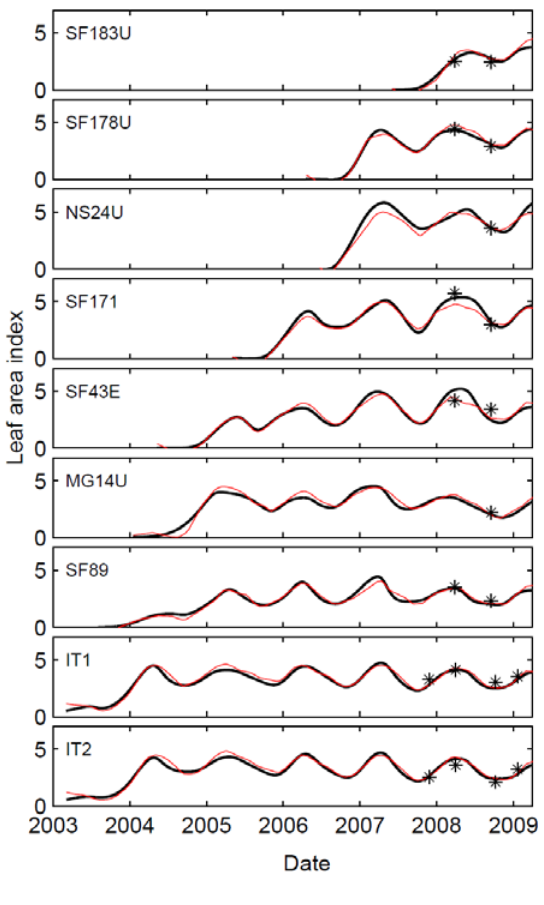
Figure 3. LAI time-series on the nine stands of Table 1, since the beginning of the rotation. The black line represents the results of the RTM inversion [14], the red line those of the index, and black stars indicate LAI values obtained from destructive EucVI corr